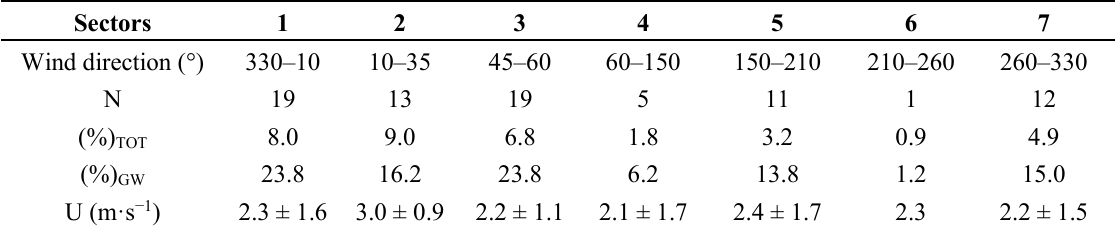
Table 1. Classification of the selected 30-min time series based on different wind direction sectors (see Figure 1). N refers to the number of runs exhibiting a wavelike pattern; (%) TOT and (%) GW refer to the percentage of runs exhibiting a wavy pattern relative to the total number of runs in each sector and relative to the total cases of GW, respectively; U represents the average mean wind associated with the wavy selected events for each sector at z = 10 m.